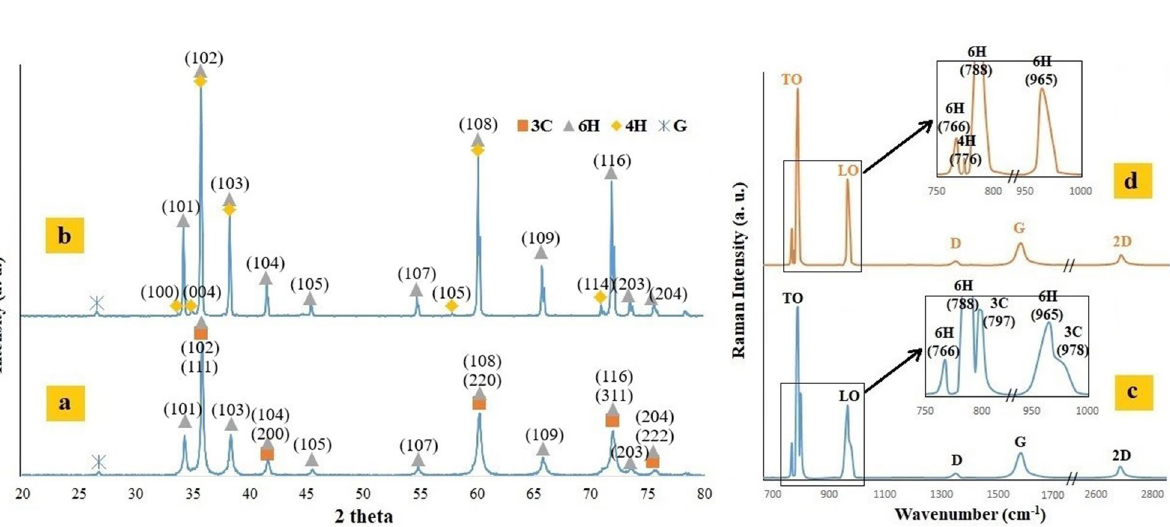
Figure 2. The XRD patterns of sample 5B1G, ( a ) before and ( b ) after the sintering process and The Raman spectroscopy of sample 5B1G, ( c ) before and ( d ) after the sintering